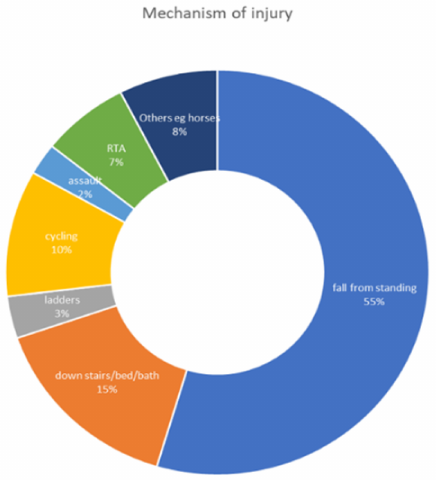
Figure 2. Percentage of the mechanisms of